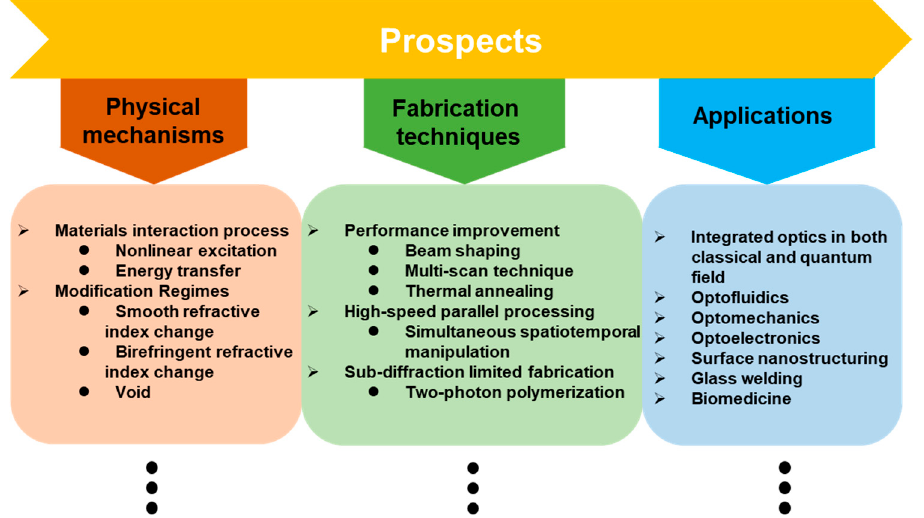
Figure 14. Prospects for femtosecond laser-fabricated photonic chips.